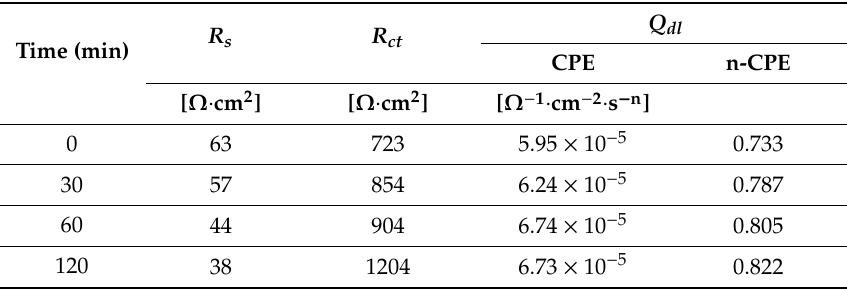
Table 8. Fitting results for EIS at different time.